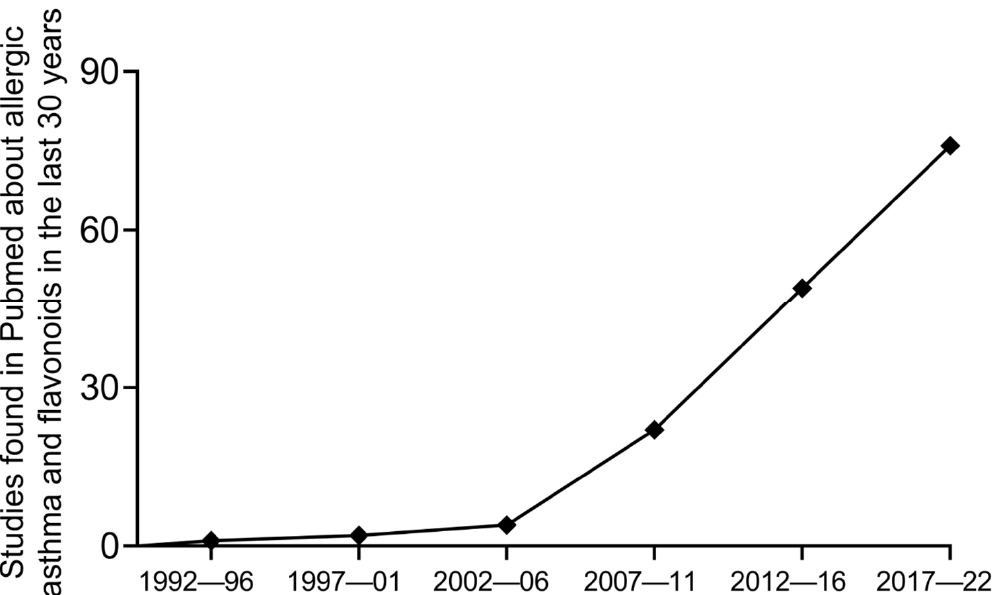
Figure 1. Original studies published on Pubmed in the last 30 years on preclinical asthma testing flavonoids. The keywords used for the search were “allergic asthma model and flavonoids”.